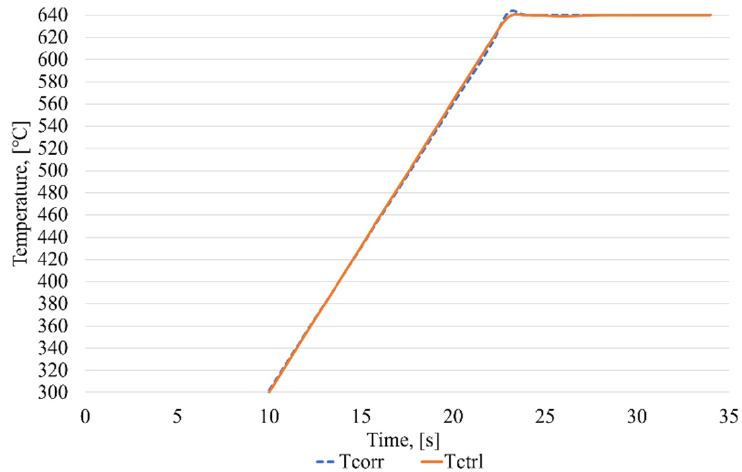
Figure 19. Induction brazing control process graph, where Tcorr—temperature values obtained from a correcting pyrometer, and Tctrl—temperature values obtained from a control pyrometer.